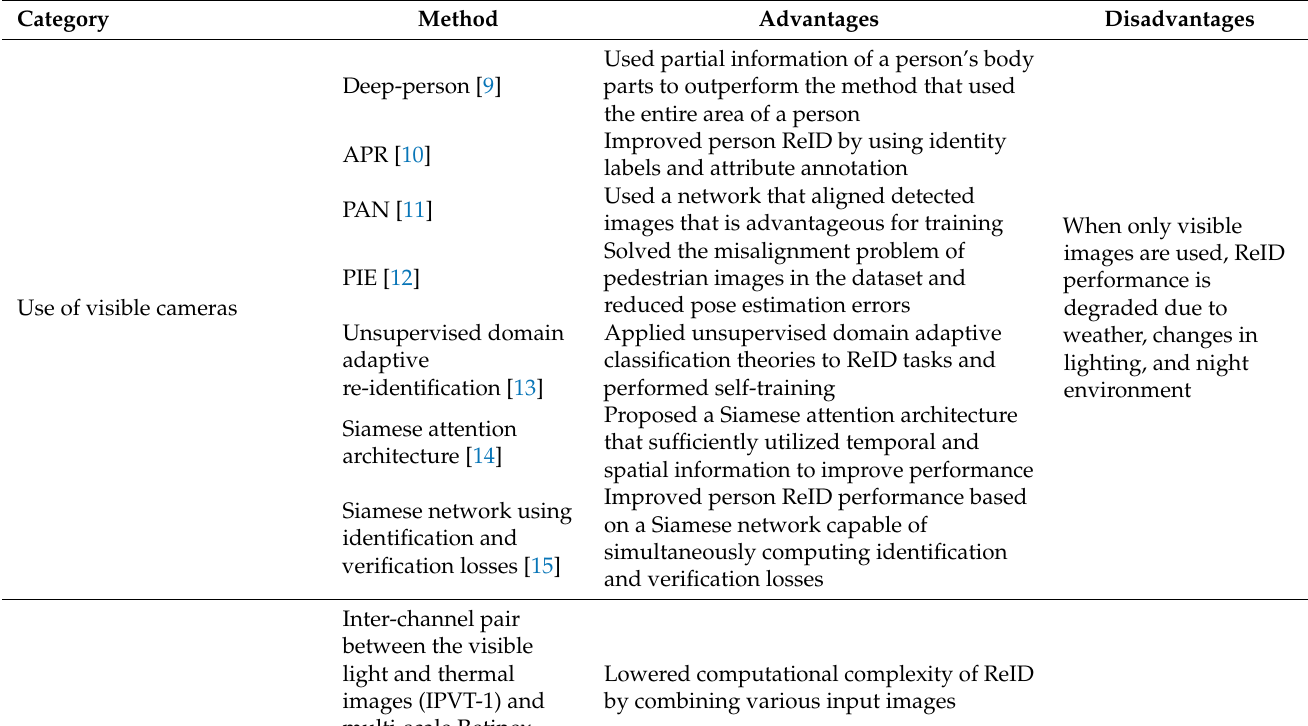
Table 1. Comparisons of previous and proposed methods on person re-identification